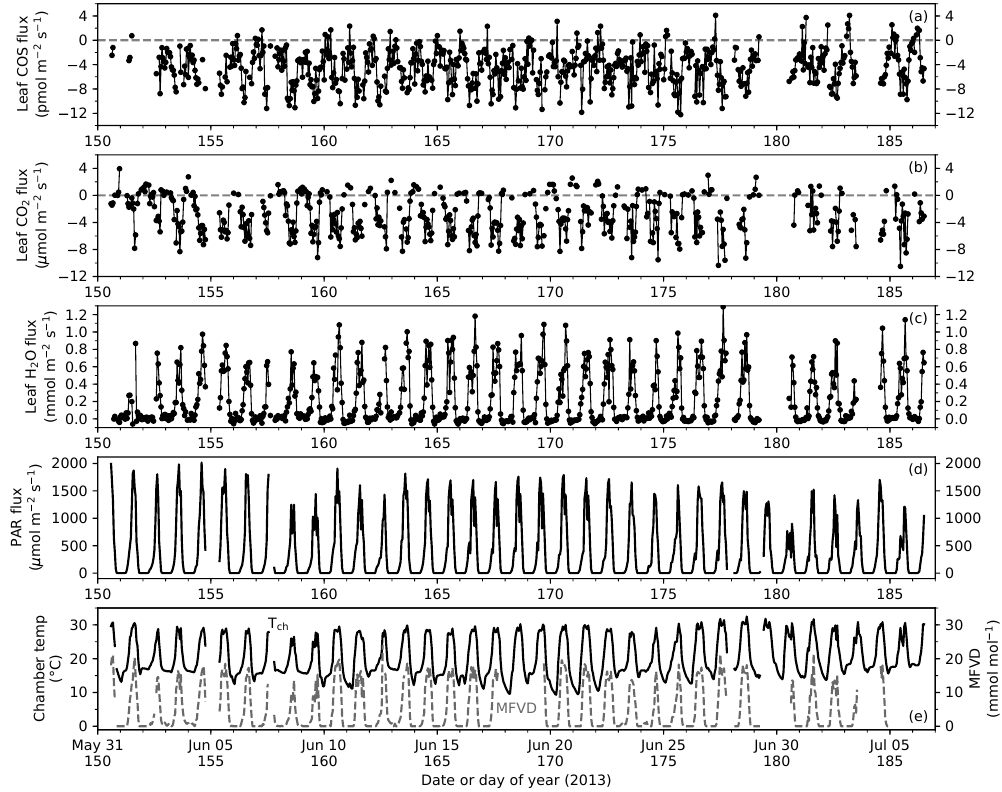
Figure 2. Time series of leaf COS (a) , CO 2 (b) and water (c) fluxes, photosynthetically active radiation (PAR) at the leaf chamber (d) , chamber air temperature ( e , black solid line; T ch ) and leaf-to-air vapor deficit in mole fraction ( e , gray dashed line; MFVD). Ticks on x -axes indicate the starts of the days